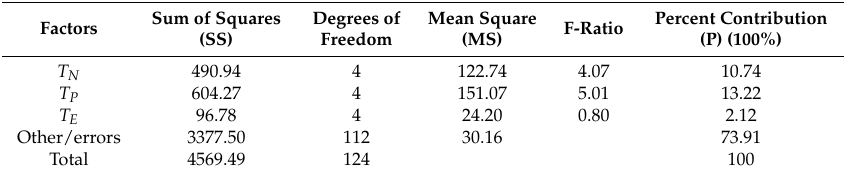
Figure 3. Tensile bars of Group No. 25: ( a ) from XY direction; ( b ) from Z direction. Table 1. Analysis of variance of tensile strength.